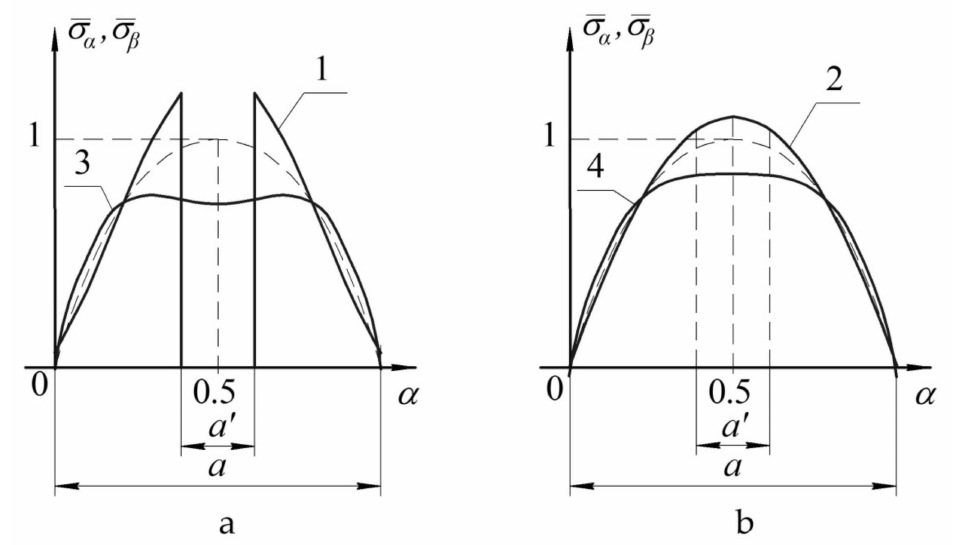
Figure 6. Distribution of normal stresses in the notched panel (1,2) and panel with a patch (3,4) on upper ( a ) and lower ( b )